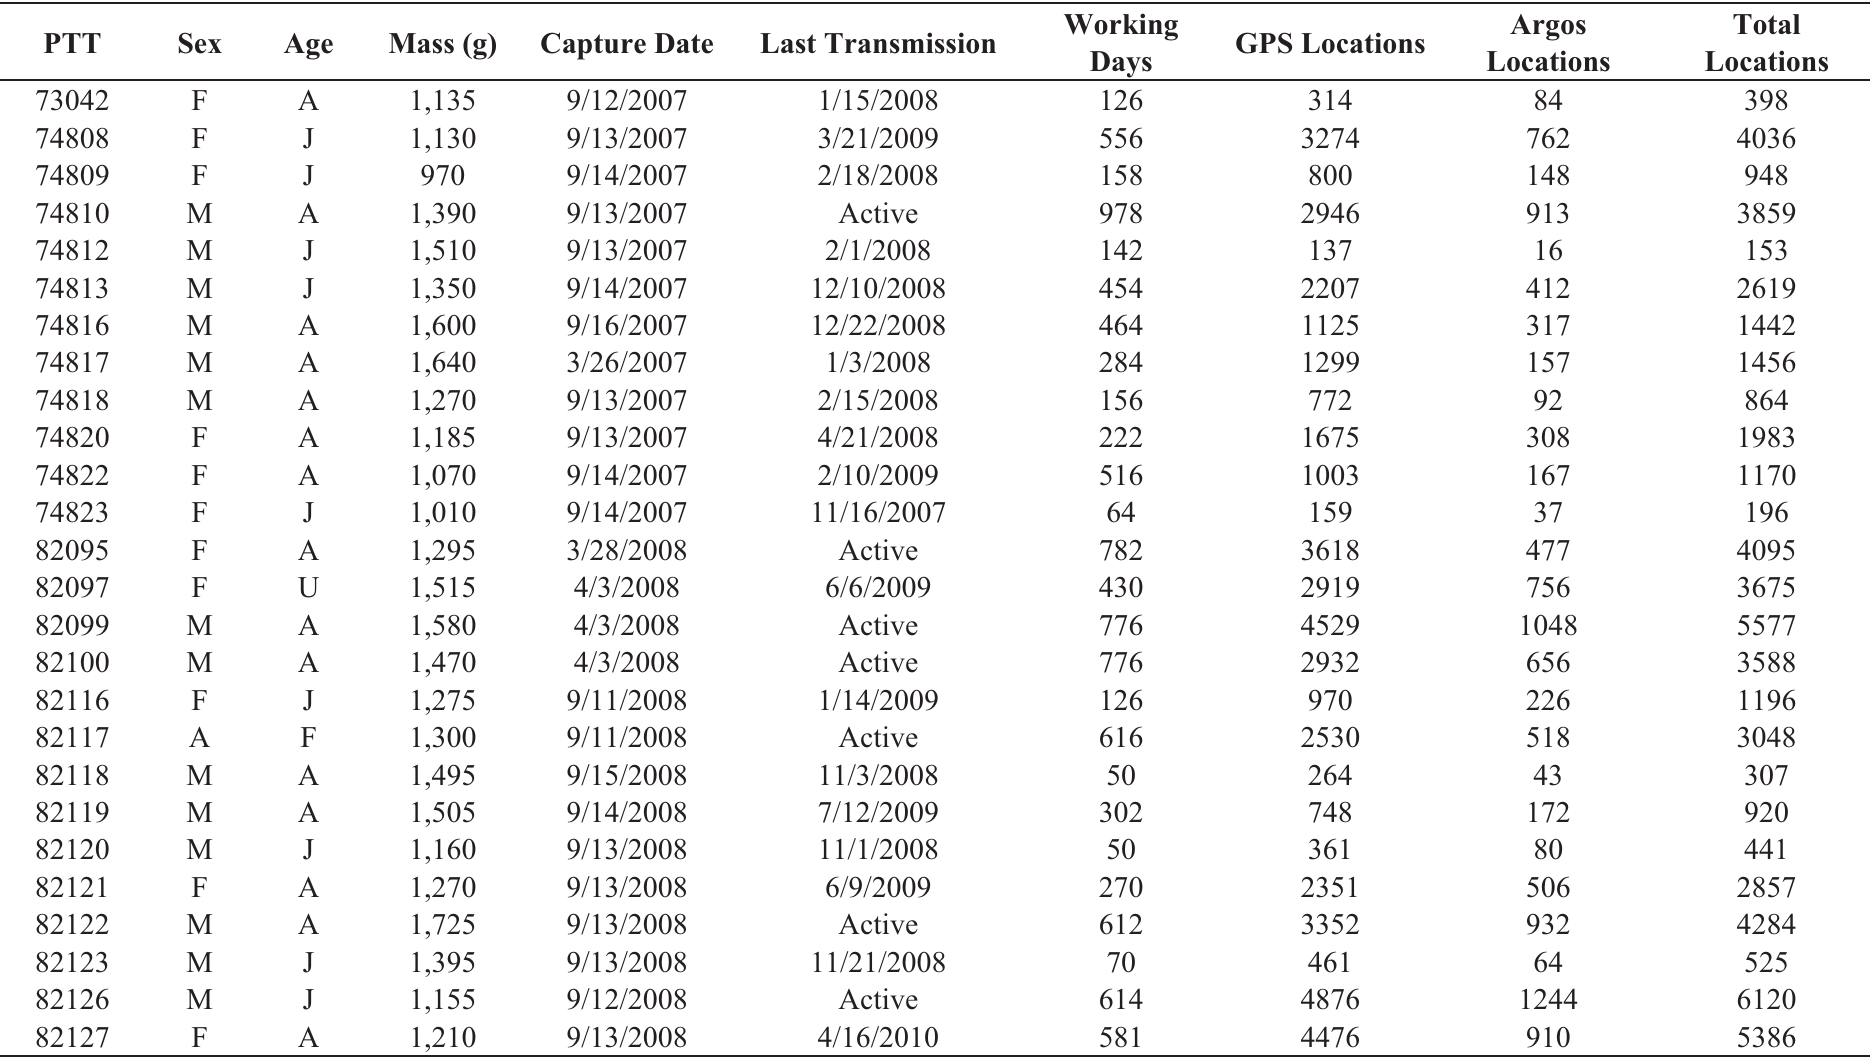
Table 1. Performance of satellite transmitters from 26 ruddy shelducks marked in 2007 – 2008 at Qinghai Lake, China through 15 May 2010. Total number of GPS and Argos locations is